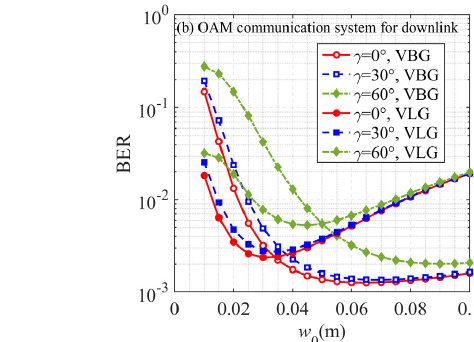
Figure 10. Average BER of air–ground OAM communication systems versus w 0 with different γ for uplink ( a ) and downlink ( b ).